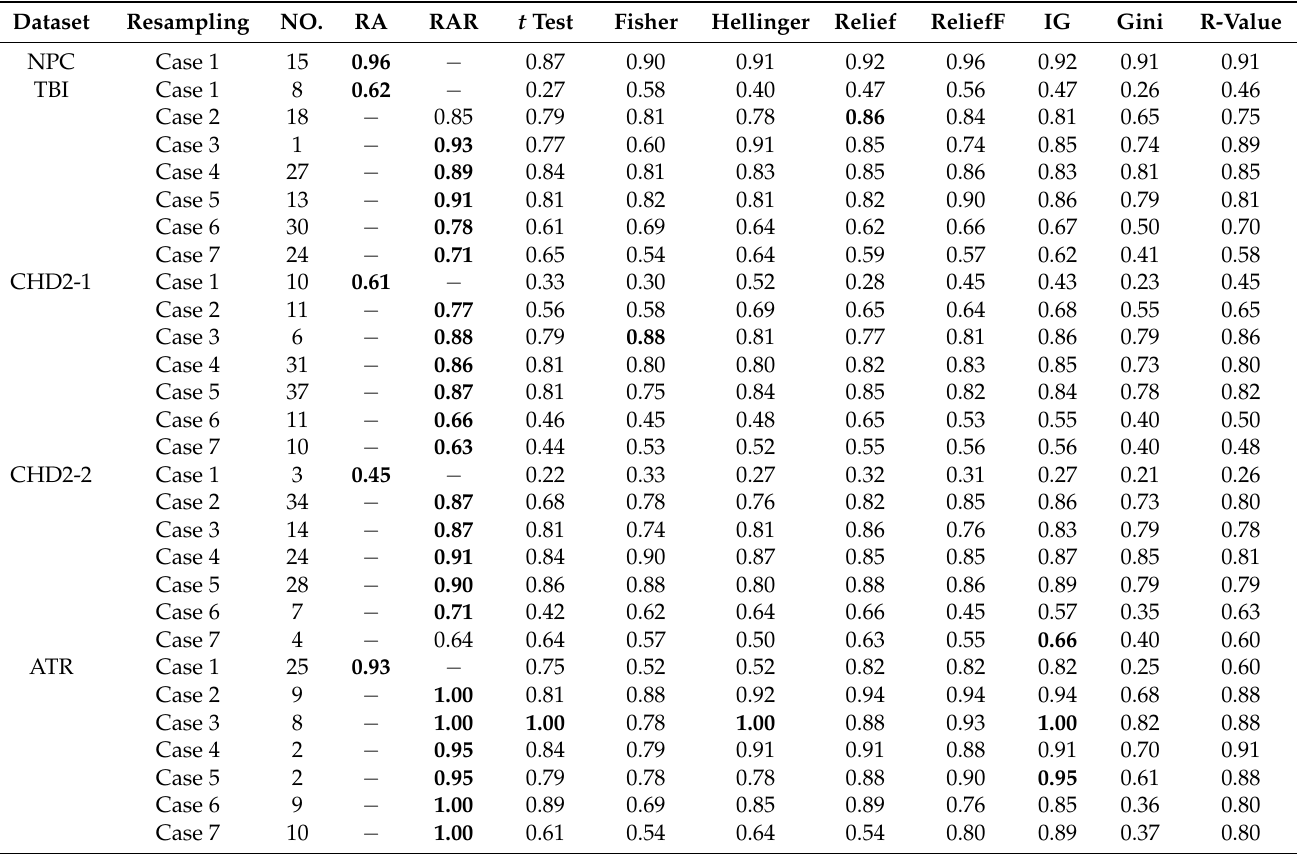
Table 4. AUCPRC from rank aggregation and eight filtering techniques (The best result is in